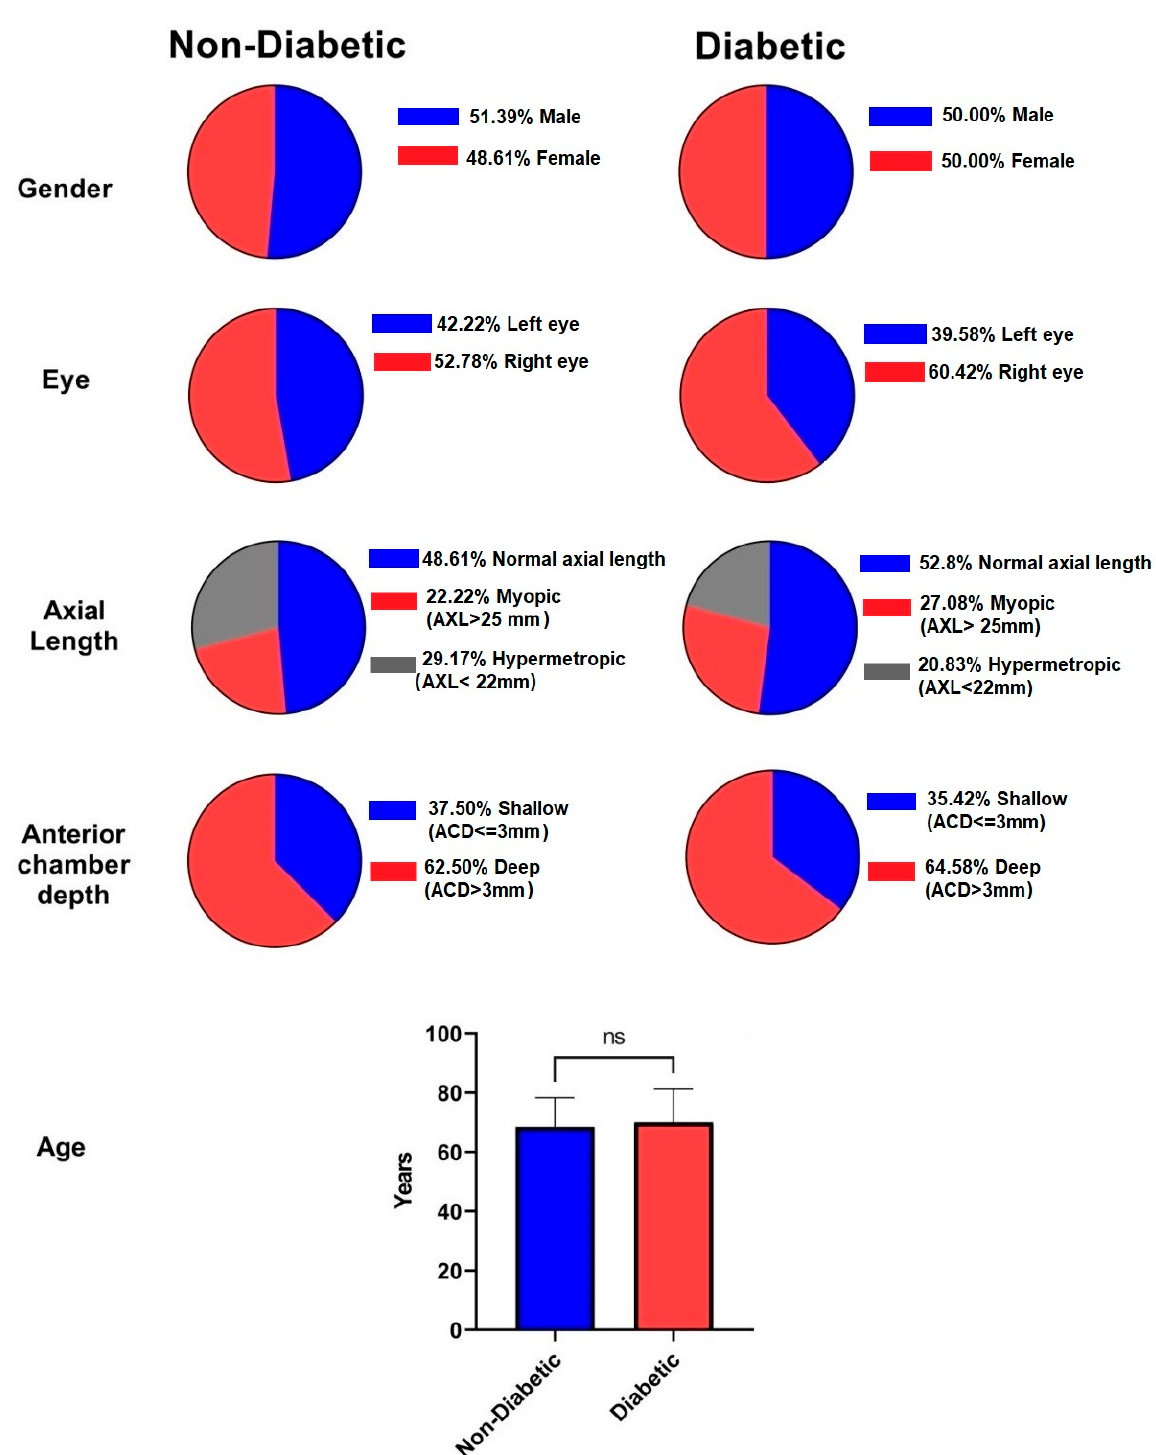
Figure 3. Combined socio-demographic and clinical characteristic of diabetic and non-diabetic groups. Legend: AXL—axial length; ACD—anterior chamber depth.